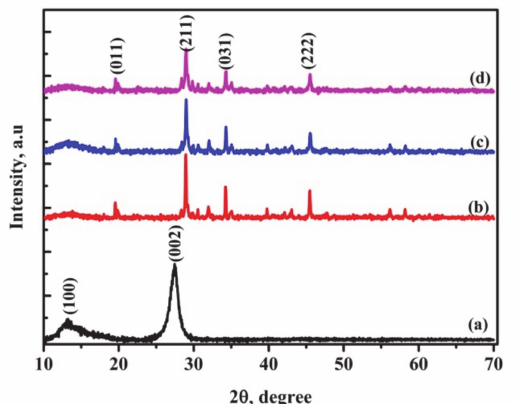
Figure 1. XRD patterns for ( a ) bulk g-C 3 N 4 ( b ) SrAl 2 O 4 :Eu,Dy ( c ) SrAl 2 O 4 :Eu,Dy / 50 wt.% g-C 3 N 4 and ( d ) 50 wt.% g-C 3 N 4 supported on SrAl 2 O 4 :Eu,Dy-0.01M SiO 2